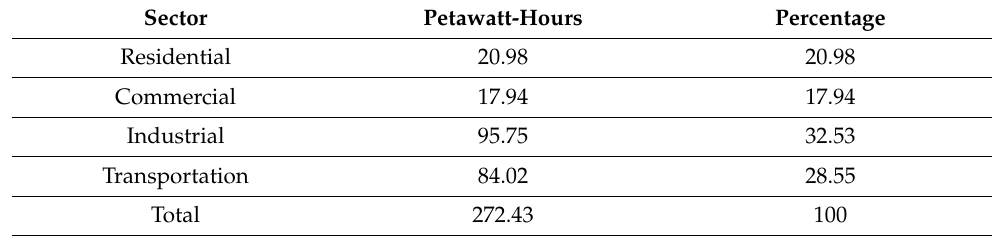
Table 1. Energy consumption by sector, 2019